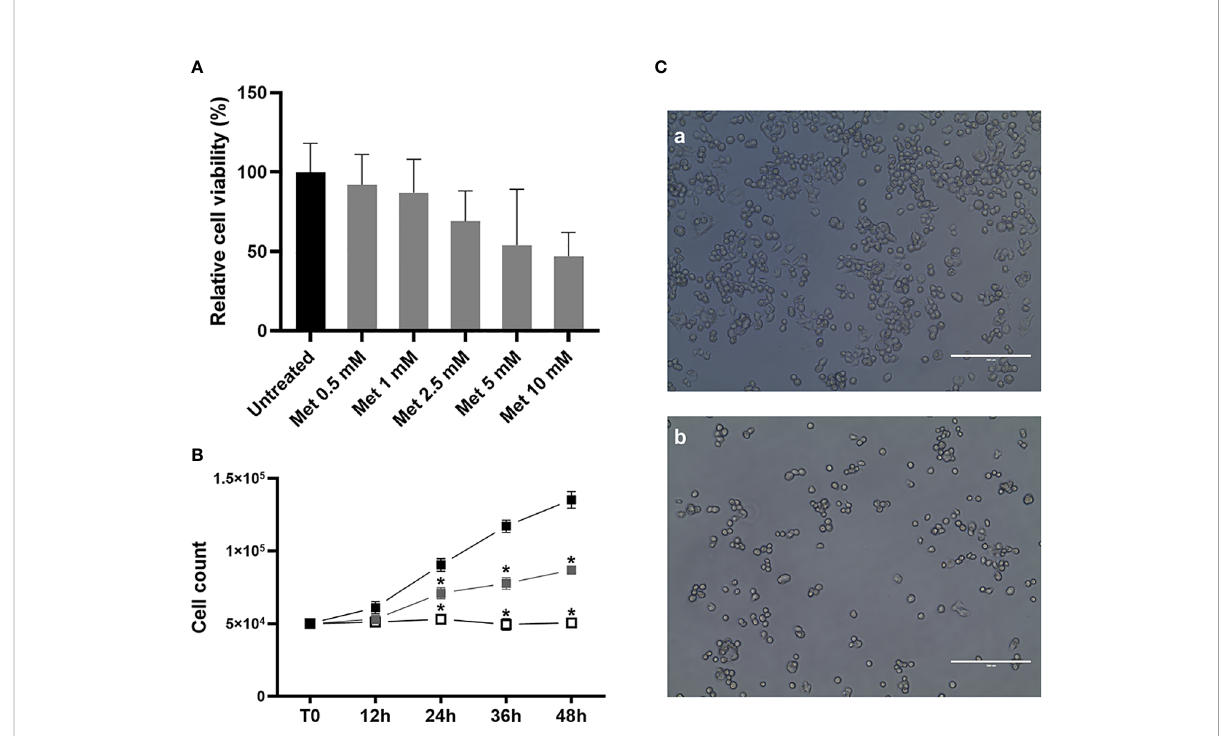
FIGURE 1 (A) MTT assay was performed to determine the IC 50 value and cell viability after 24 h treatment with metformin (Met), at increasing concentrations (from 0.5 mM to 10 mM). Cell viability is the quanti fi cation of live cells and is expressed as the relative percentage to untreated controls. IC 50 value (that is, the concentration of Met which exhibited 50% cell viability in SEM-1 cells) was 5 mM. Histograms are representative of a minimum of three replicates. Cell viability data are shown as mean + s.e.m. (B) Growth curves of SEM-1 cells, either untreated (black squares) or exposed to Met 1 mM (gray squares) and 5 mM (white squares) for up to 48 h, as obtained by the Trypan Blue dye exclusion counting method. * p < 0.05 vs untreated cells. (C) Representative pictures of SEM-1 cells in adherent culture conditions: a) untreated; b) exposed to Met 5 mM for 24 h. Scale bar: 200